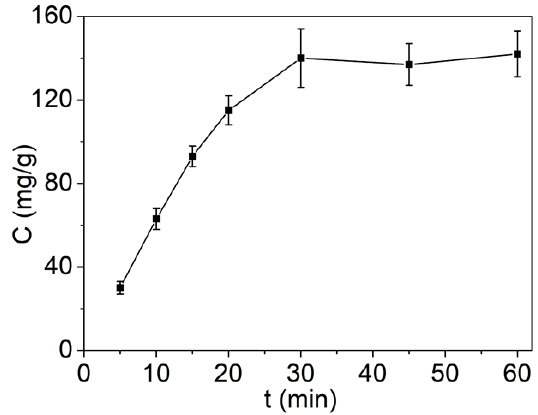
Figure 6. Effect of contact time on Pb 2+ adsorption (50 mg/L of Pb 2+ , 200 mg/mL of adsorbent, 1 mL solution, pH = 7, room temperature).